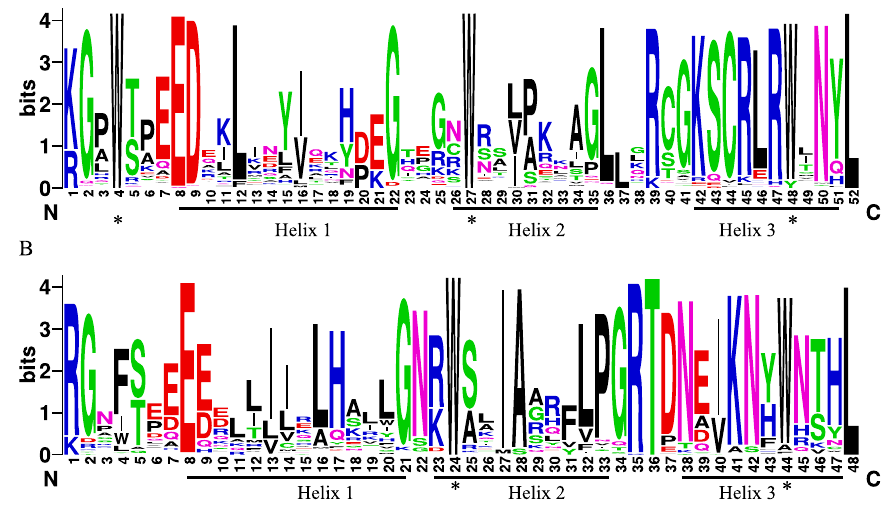
Figure 3. Highly conserved R2 and R3 MYB repeats across all R2R3-MYBs in pecan. Sequence logos of R2 ( A ), and R3 ( B ) repeats were generated by WebLogo based on the 153 pecan R2R3-MYB domain sequences. The height of each stack represents the conservation of the given position of MYB repeat sequences, and the height of different letters within each stack reveals the relative frequency of the amino acid. The asterisks ( * ) represent the conserved tryptophan residues (W) in the MYB repeats.